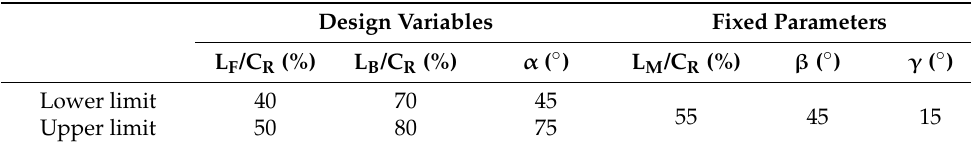
Table 4. Design space for optimization.